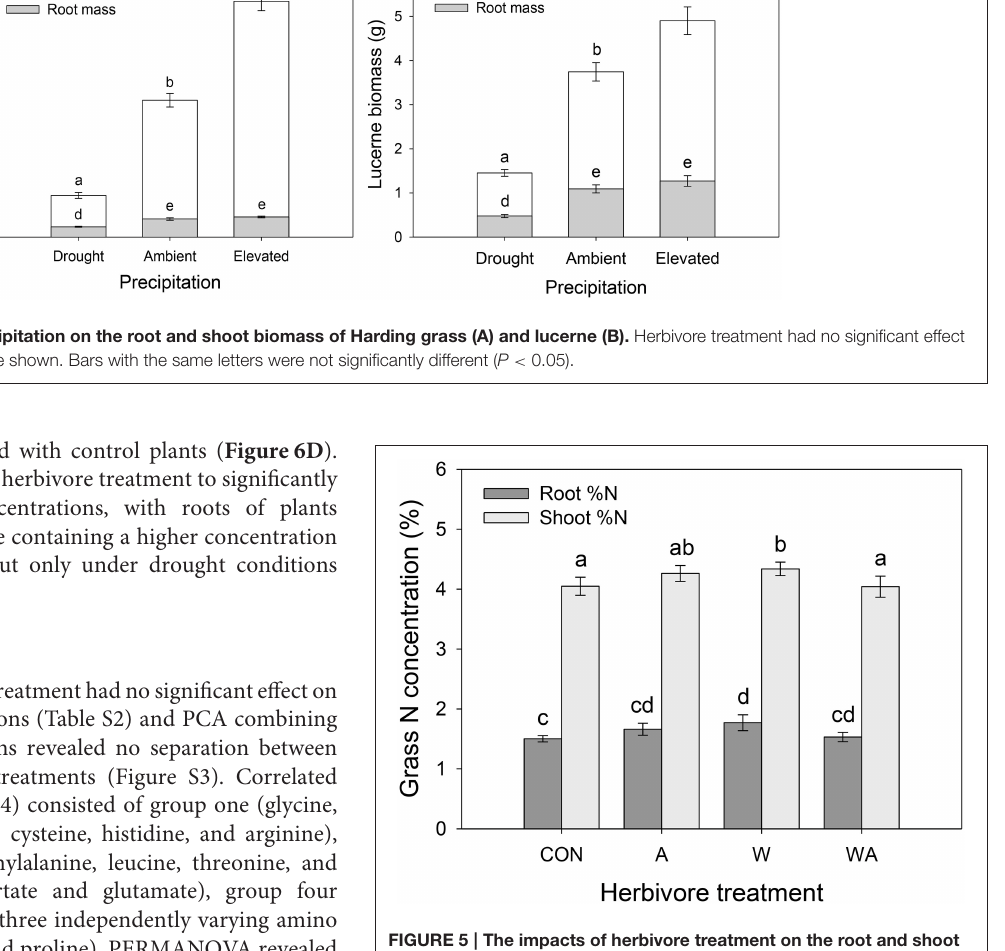
FIGURE 5 | The impacts of herbivore treatment on the root and shoot nitrogen concentrations of Harding grass. CON were the control plants (no insects), A had aphids alone, W had weevils alone, and WA had both insects. Mean values ( ± SE) are shown. Bars with the same letters were not significantly different ( P <